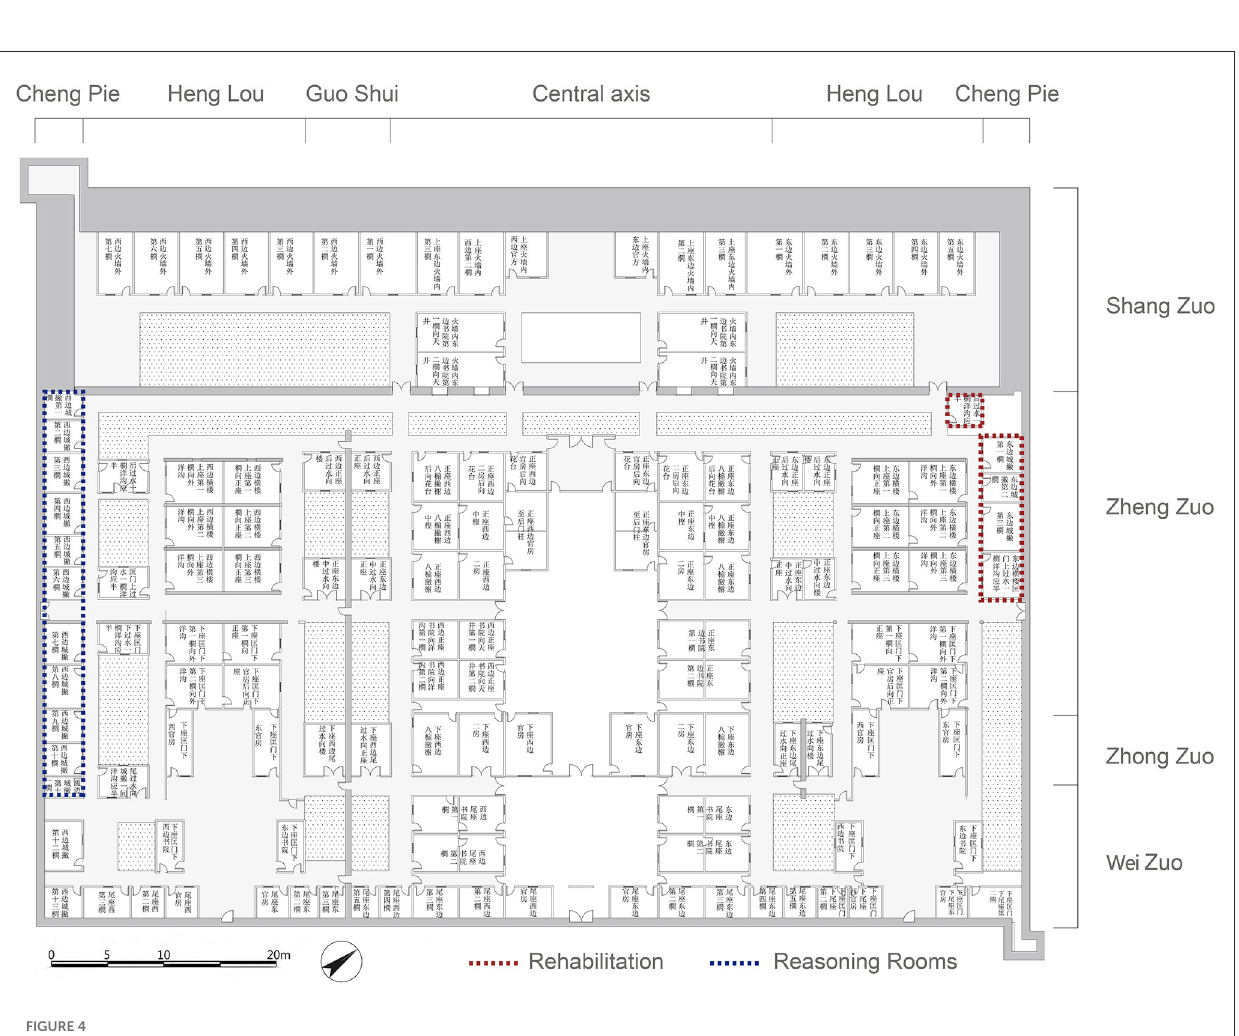
FIGURE4 Detail of